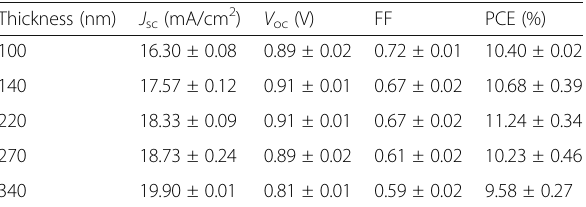
Table 1 Photovoltaic parameters of the perovskite solar cells with various perovskite thicknesses Thickness (nm) J sc (mA/cm 2 ) V oc